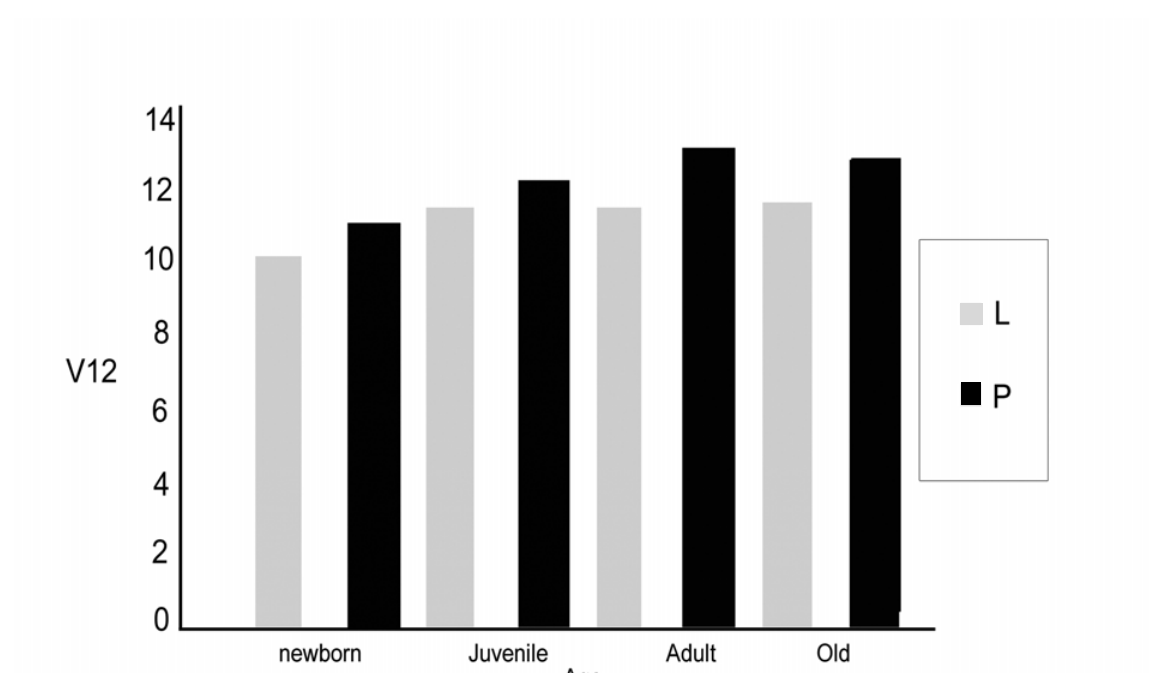
F IG . 6.- From incisor alveolar distance to the point between articular and angular (V 12) in different age classes; L: M. libycus P: M.